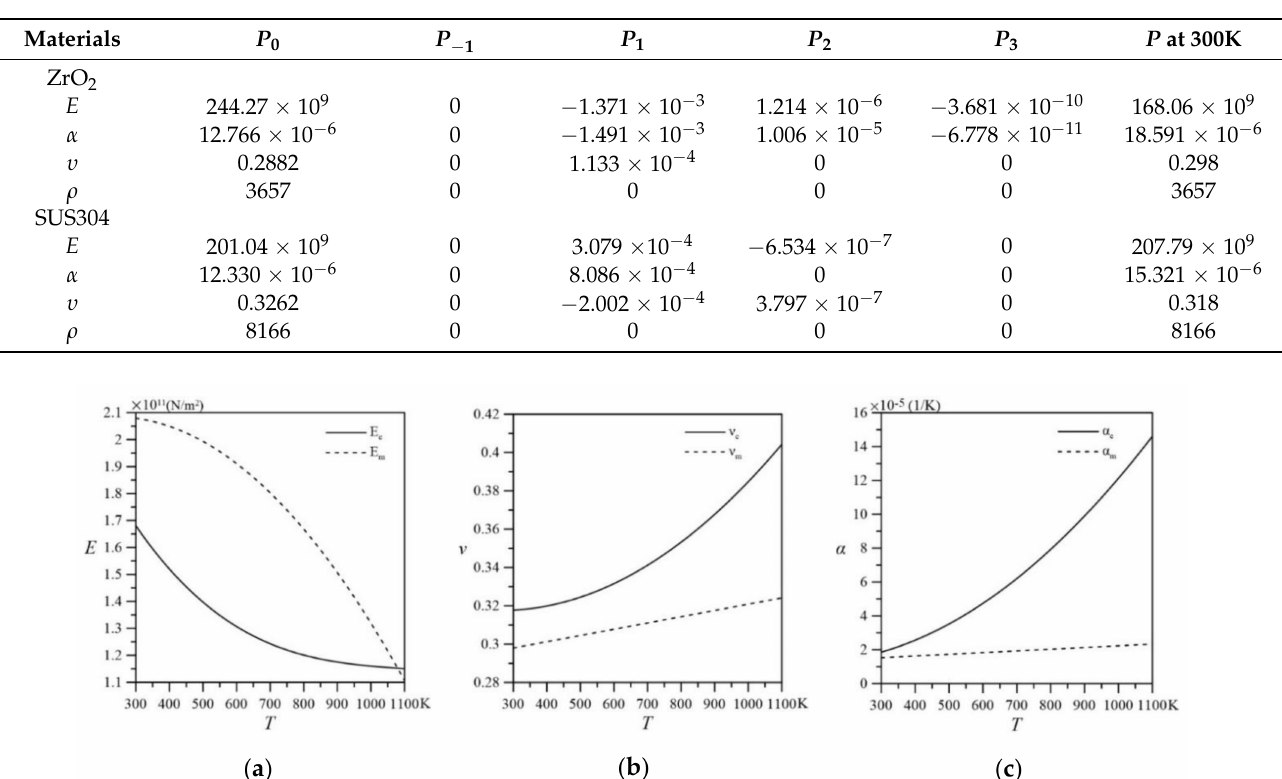
sets of Pareto-optimal solutions of the undetermined coefficients κ p , κ b , and κ c , in which 200 initial populations are randomly generated, in which the ranges of κ p , κ b , and κ c are